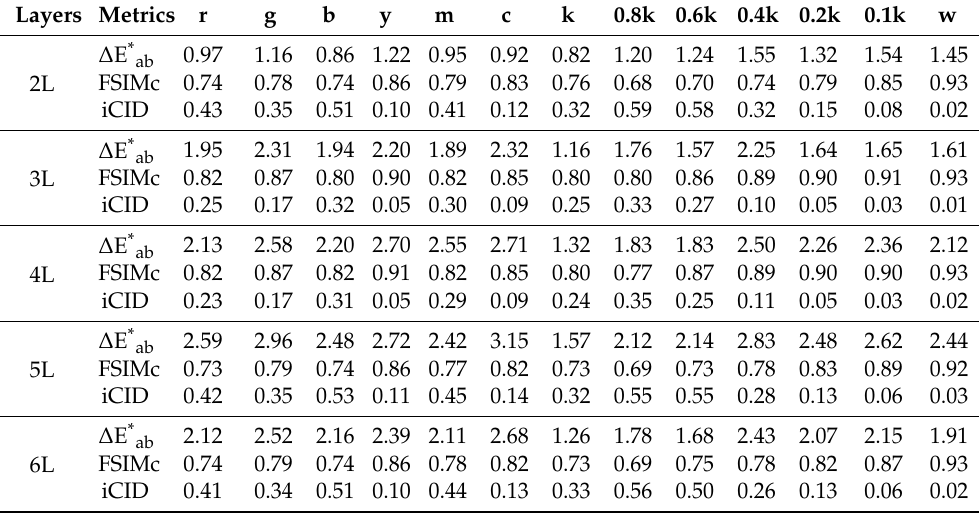
Table 4. Averaged ∆ E * ab , FSIMc, and iCID values of nine controlled